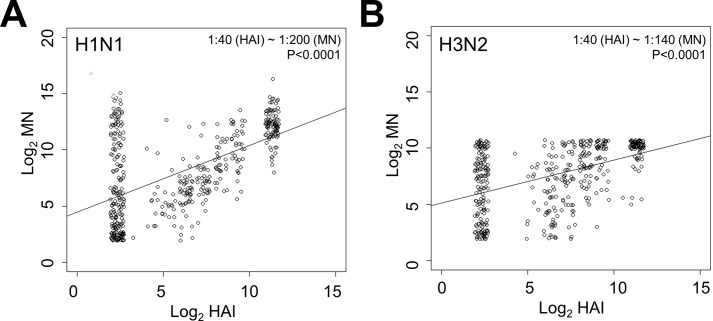
Microneutralization (MN) and hemagglutination inhibition (HAI) titres are highly correlated for seasonal influenza subtypes H1N1 and H3N2.Log-transformed MN and HAI titres for subtypes A) H1N1 (A/Brisbane/59/2007) and B) H3N2 (A/Brisbane/10/2007) are presented, along with the significance of correlation as determined by linear regression.